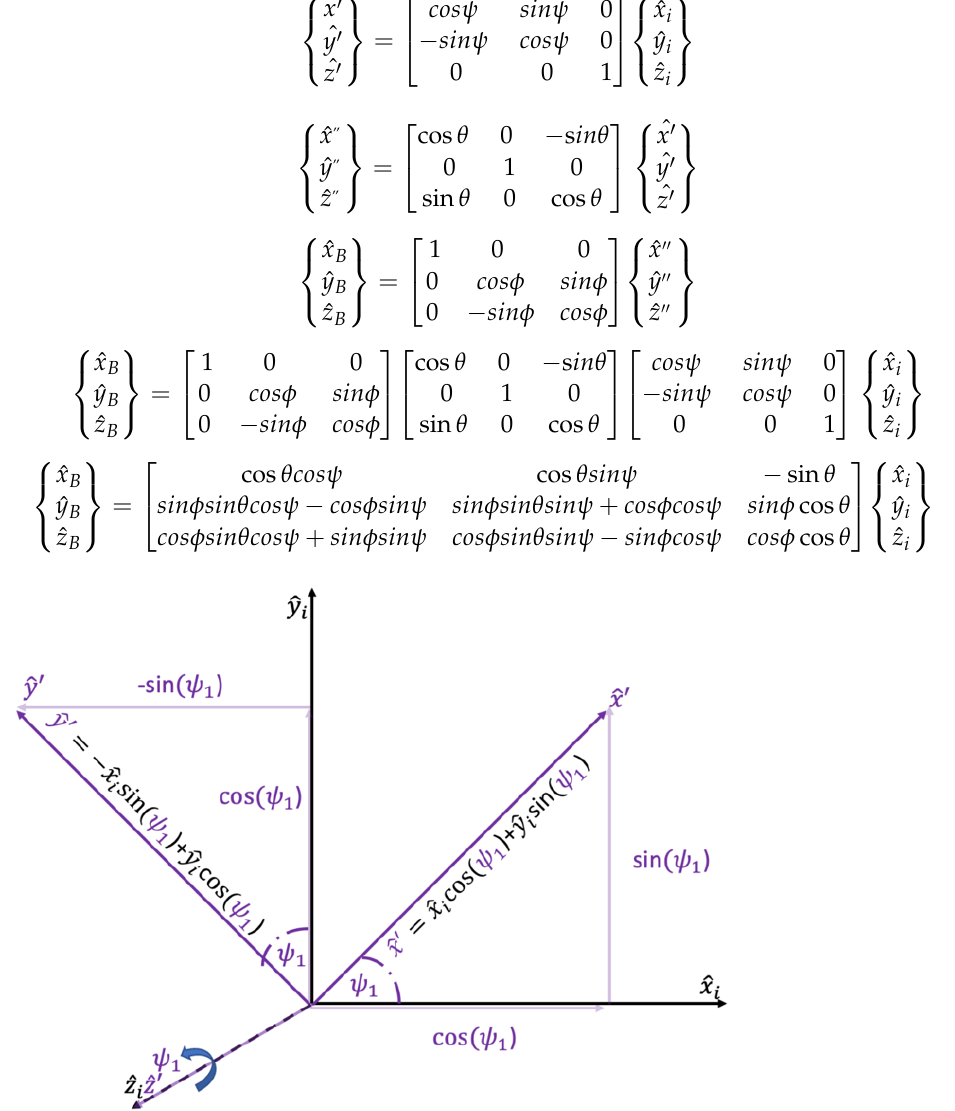
Figure 2. 3-rotation about the 𝑧 𝑖 ̂ and 𝑧′̂ axes [23].